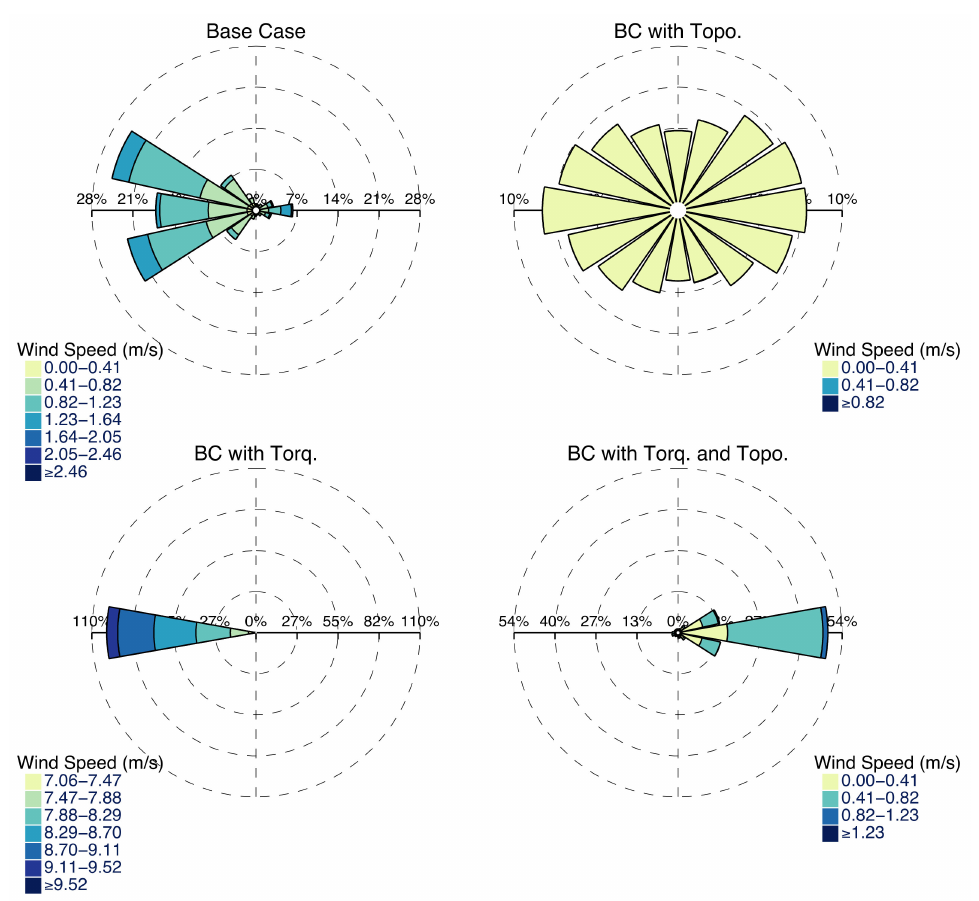
Figure 6. Downwind wind rose diagrams (wind directions from the center out) for the tropics ( +/ − 30 ◦ ) for one Titan year. Placement is the same as Figure 5. Note the changes in